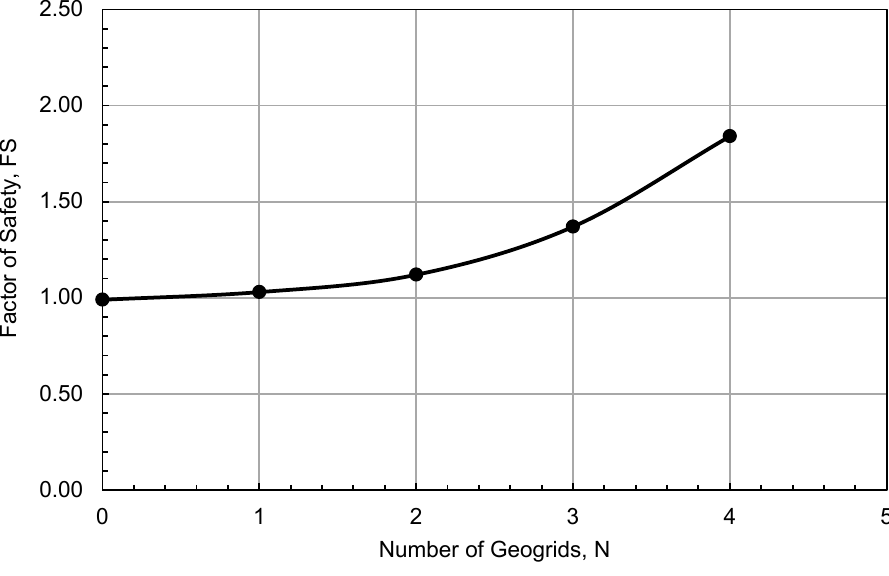
Figure 12. Variation in FS with N (1V/2H slope) (FEM).